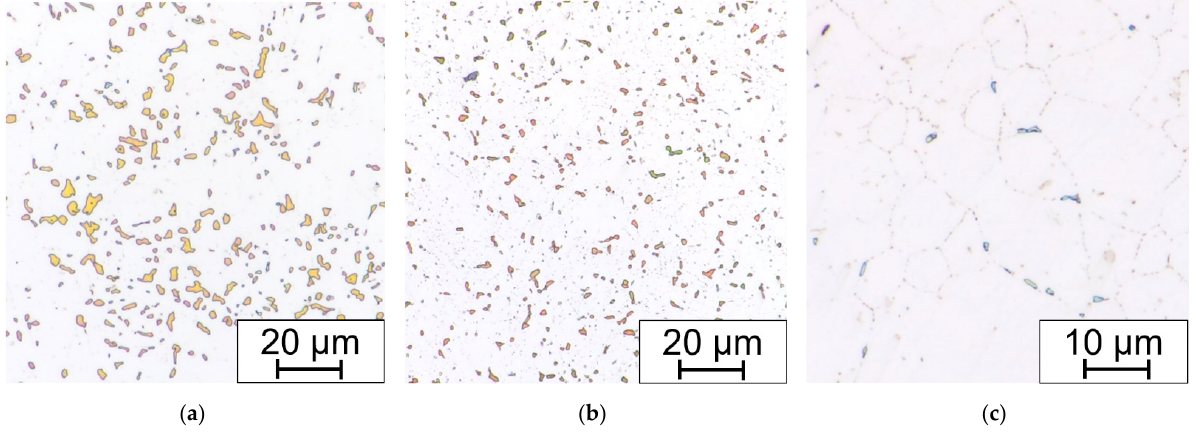
Figure 14. ( a ) Compression-stressed fiber; ( b ) tension-stressed fiber; and ( c ) neutral fiber; bend without HT, all aged 650 °C/15,000 h and electrolytic etched in 20% aqueous NaOH (1.5 V DC, 1 s). The weld joint structure in both states, with and without solution annealing, consists of gamma austenite. The microstructure of samples without HT consists of grains with ragged areas inside lined with fine precipitates. These areas, mainly after slight overetching, may be misinterpreted as delta ferrite (Figure 15a).